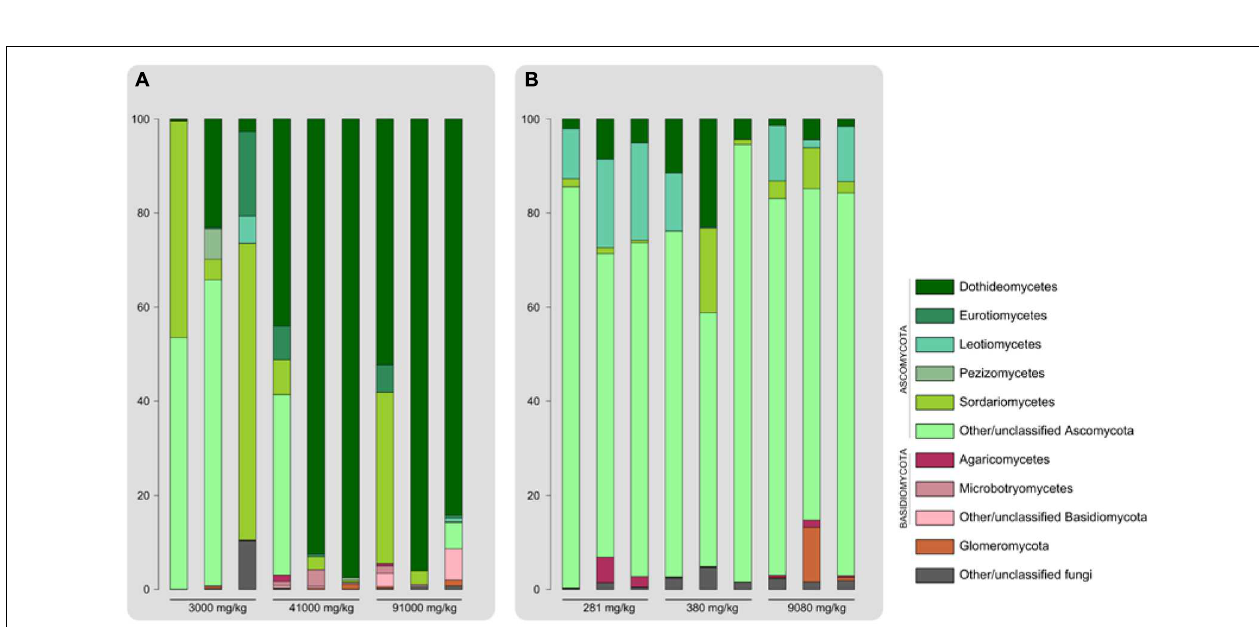
FIGURE 3 | Major classes of endophytic fungi recovered from roots of (A) E. erythropoda and (B) P. balsamifera Bar length is proportional to relative number of 454 reads.